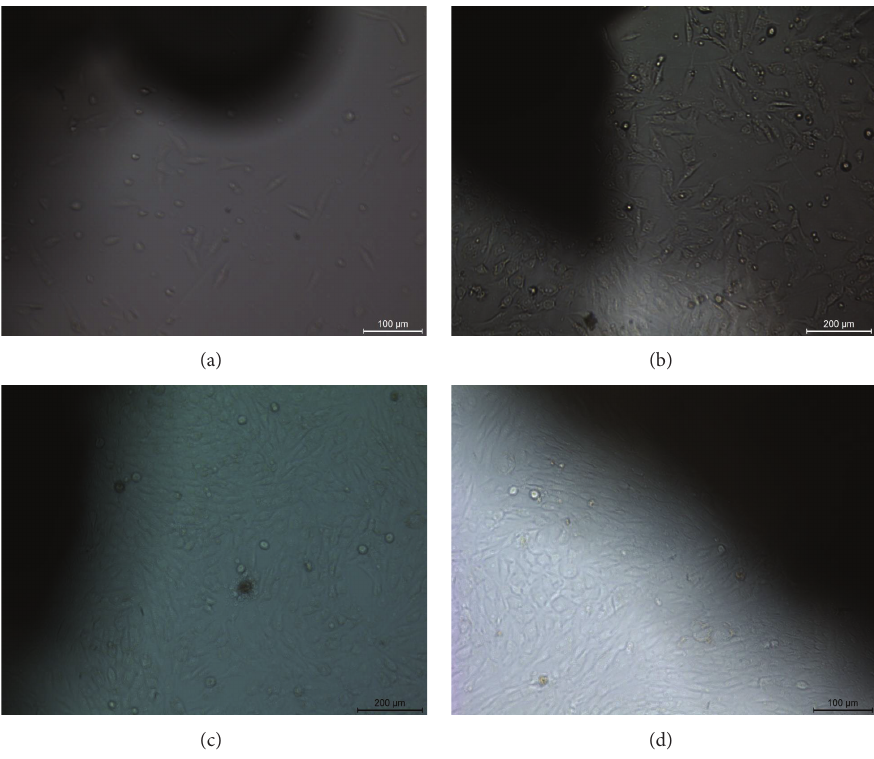
Figure 6: Phase contrast microscopy images of MG63 cells cultured on the s-HA/PA composite for 1 day (a), 3 days (b), 5 days (c), and 7 days